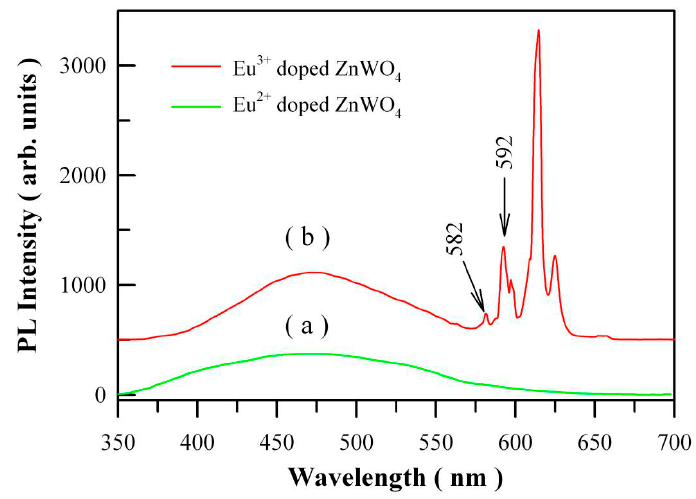
Figure 15. ( a ) PL spectrum of Eu 2+ doped ZnWO 4 with the doping concentration of 1 mol %; ( b ) PL spectrum of Eu 3+ doped ZnWO 4 with high resolution to show the 5 D 0 → 7 F 0 emission. The excitation wavelength was 325 nm.